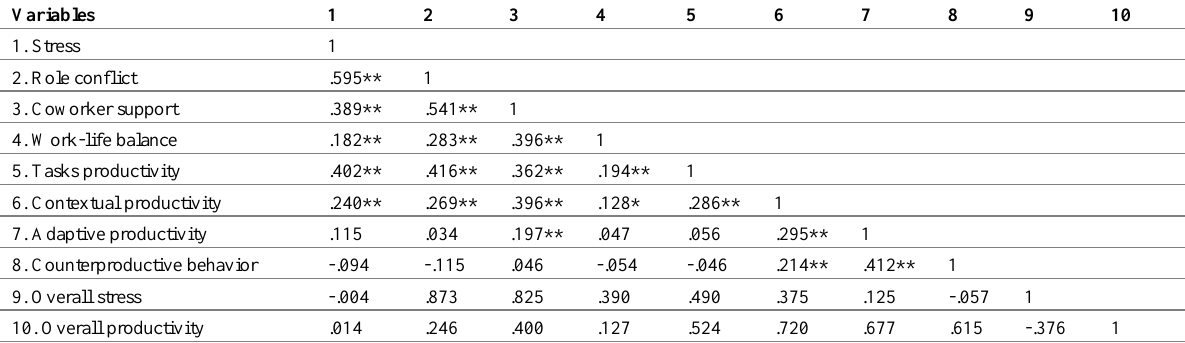
Table 1: Bivariate Correlation of Job Stress and Productivity